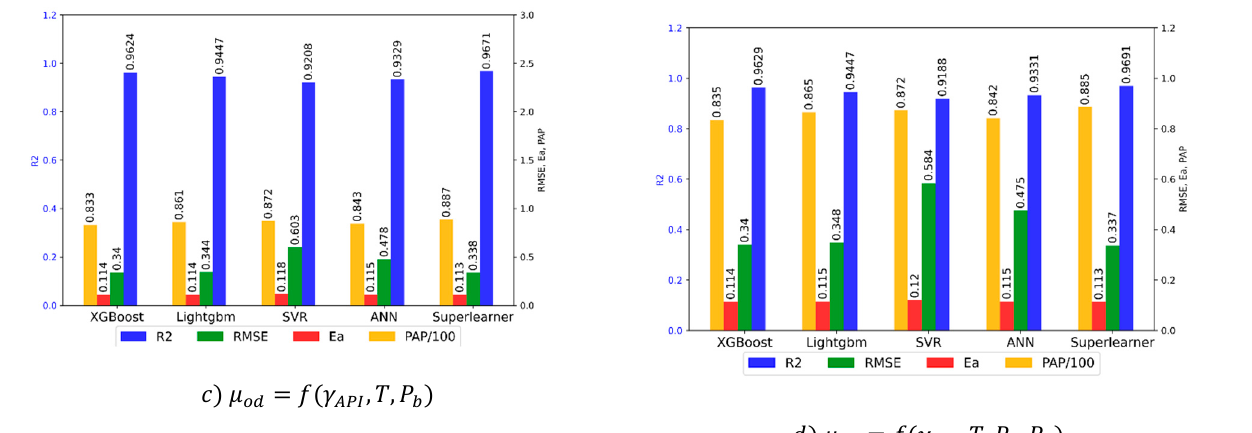
Figure 3. Statistical results (metric analysis) of different machine learning (ML) algorithms for µ od of different functional for, prediction for the testing dataset.